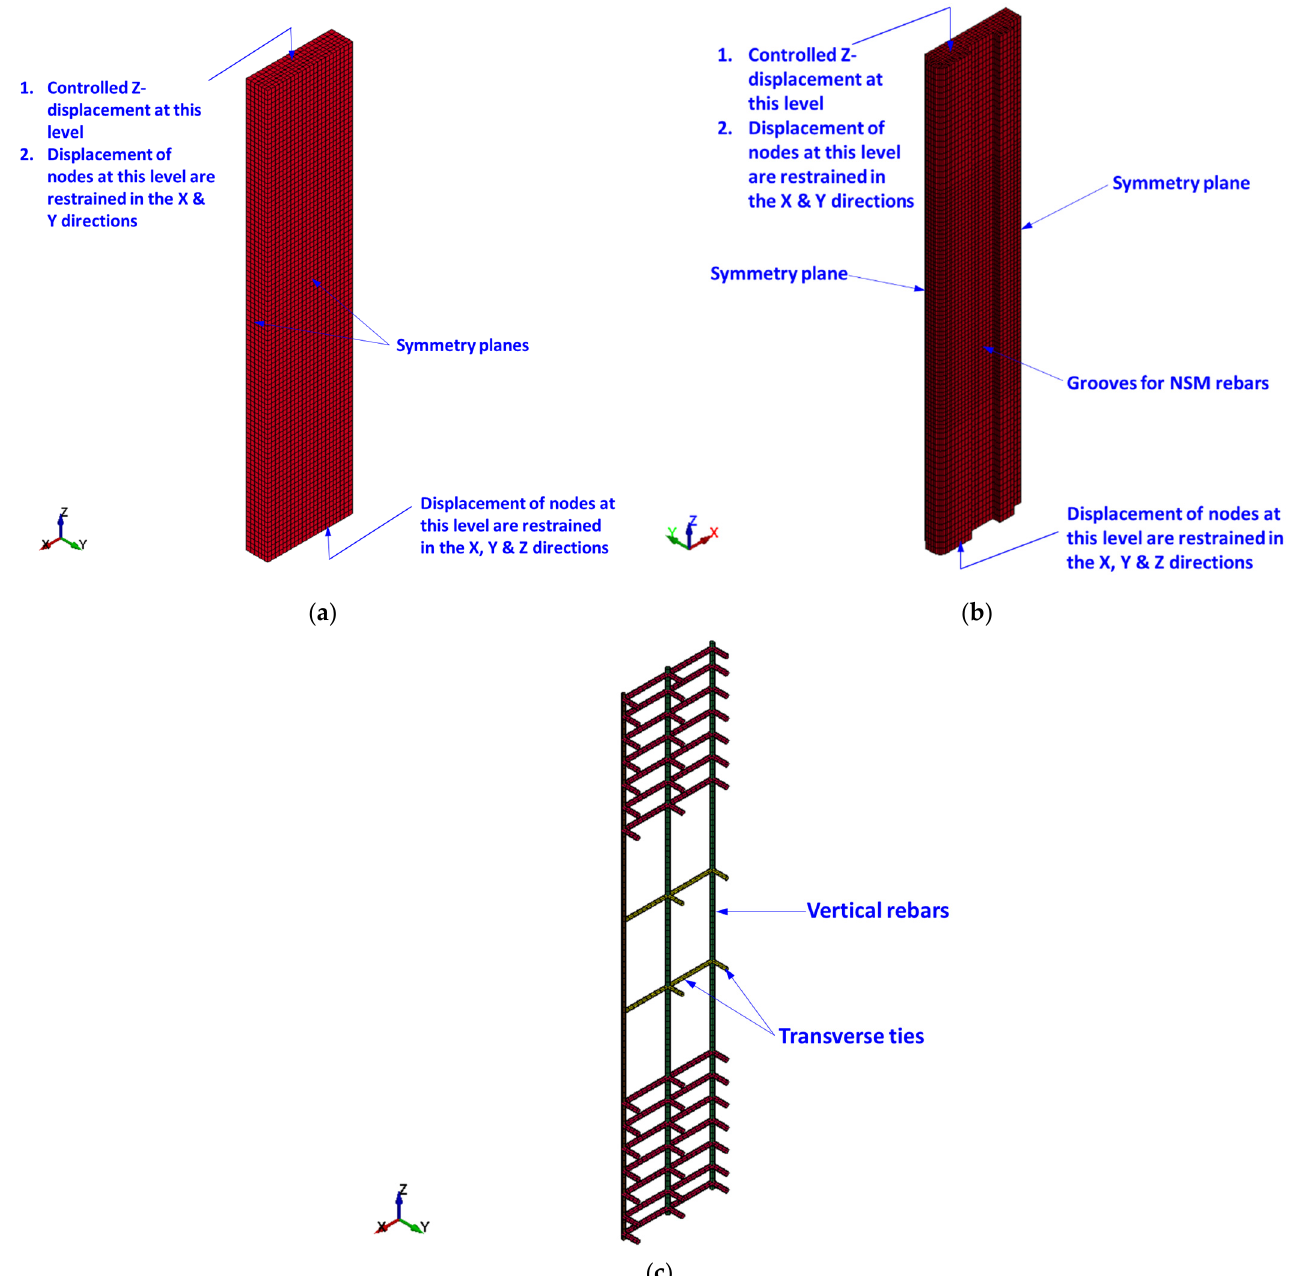
Figure 11. FE geometry for concrete volume and steel reinforcement of specimens: ( a ) concrete mesh for specimens C, S1, and S2; ( b ) concrete mesh for specimens S3 and S4; ( c ) mesh of reinforcement cage of all specimens.